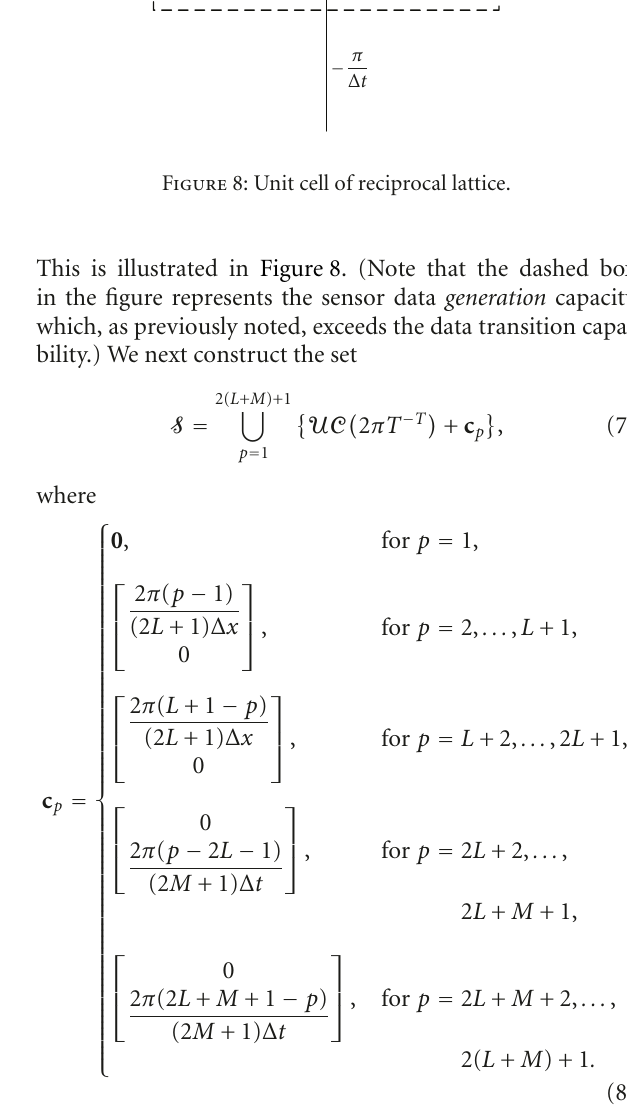
Figure 7: The nonuniform sampling pattern considered.